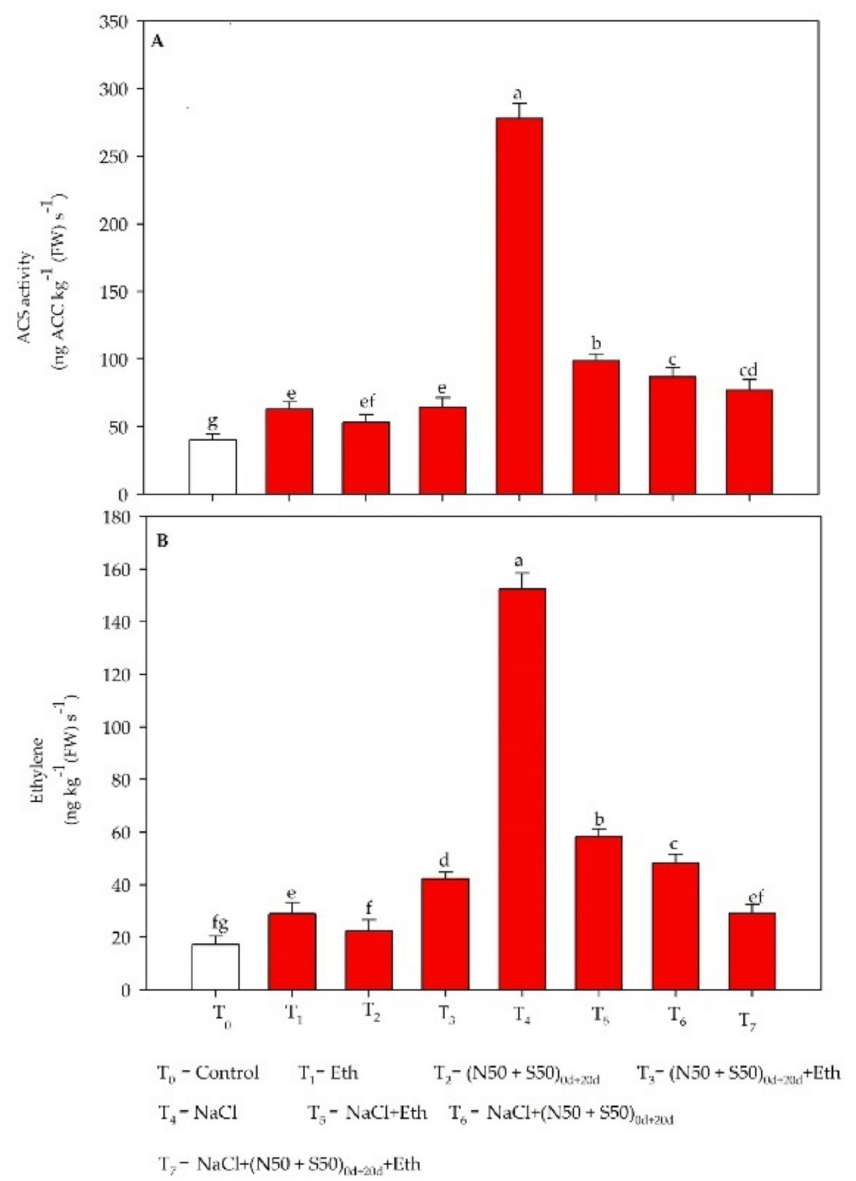
Figure 3. ( A ) Activity of 1-aminocyclopropane carboxylic acid synthase (ACS) and ( B ) ethy- lene production in mustard plants at 40 DAS. Plants were raised with split doses of N and S (50 + 50 mg kg − 1 soil) at sowing time (0 DAS) and at 20 DAS, and were treated with 200 µ L L − 1 ethephon (Eth) in the absence or presence of 100 mM NaCl. Values are presented as means ± SE ( n = 4). Data followed by the same letter are not significantly different by LSD test at p < 0.05. DAS: days after sowing; FW: fresh